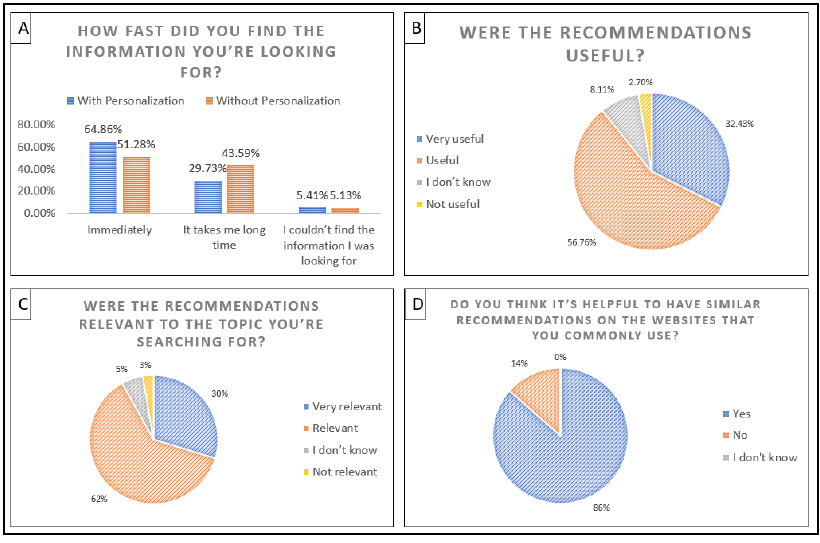
Fig. 4. Results of user experience